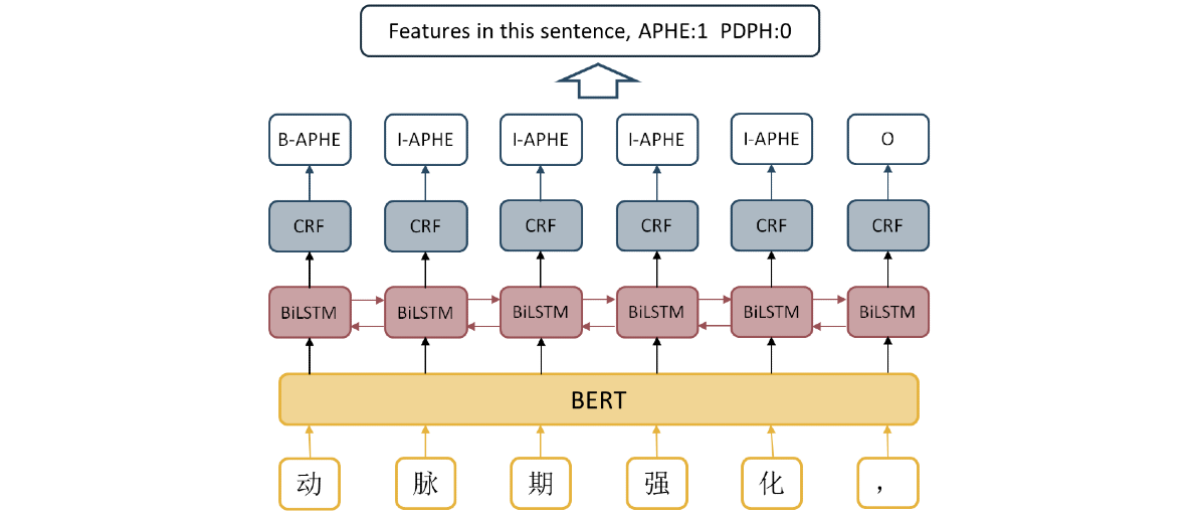
Figure 2. The architecture of the BERT-BiLSTM-CRF model for the recognition of APHE and PDPH. BERT: Bidirectional Encoder Representations from Transformers; BiLSTM: bidirectional long short-term memory; CRF: conditional random field; APHE: hyperintense enhancement in the arterial phase; PDPH: hypointense in the portal and delayed